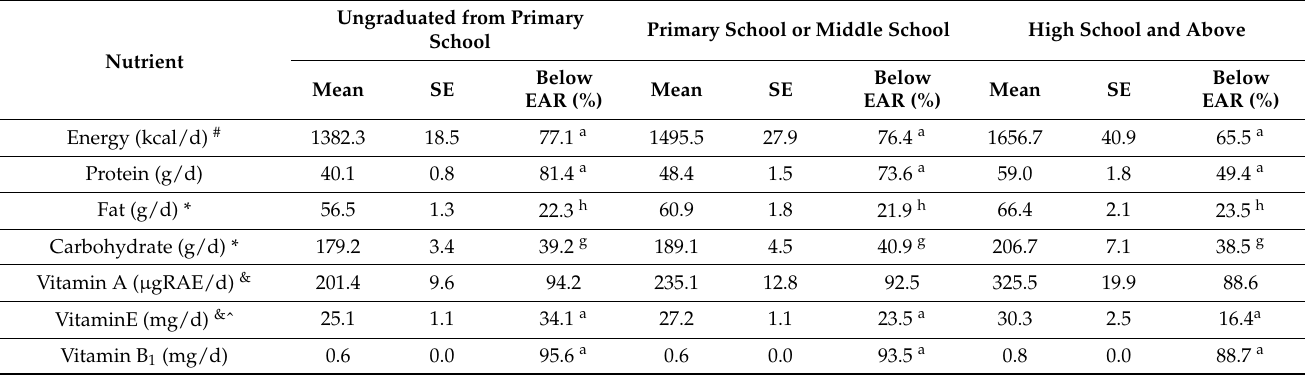
Table 5. Dietary daily intake of energy and nutrients and the prevalence of deficiency in the subjects aged 80 and above in different education